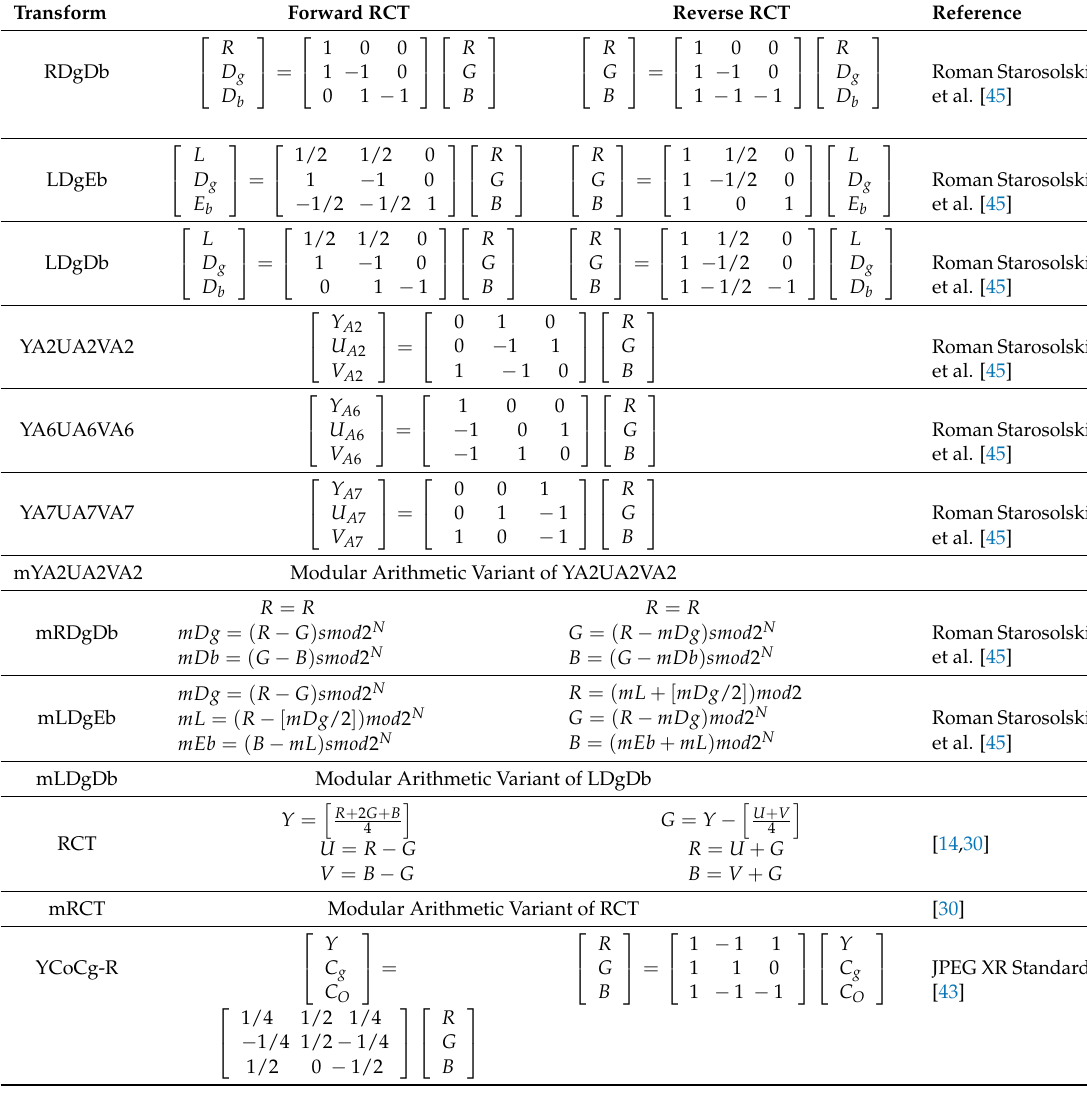
Table 1. List of RCTs and their forward and reverse